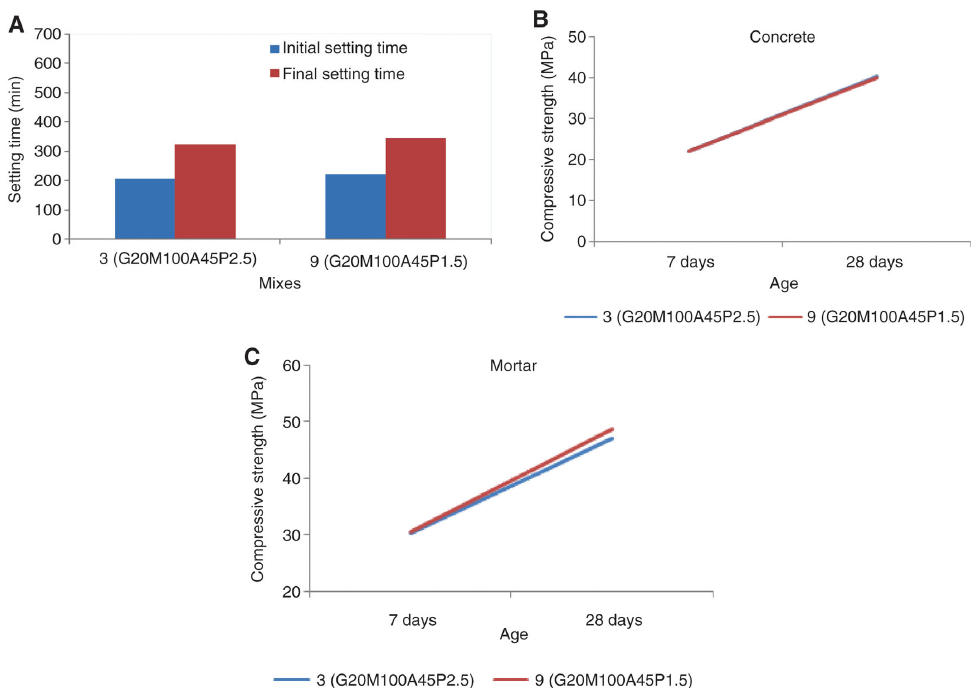
Figure 7: Effect of proportions of SS/SH on the setting time (A), compressive strength of geopolymer concrete and mortar (B) and